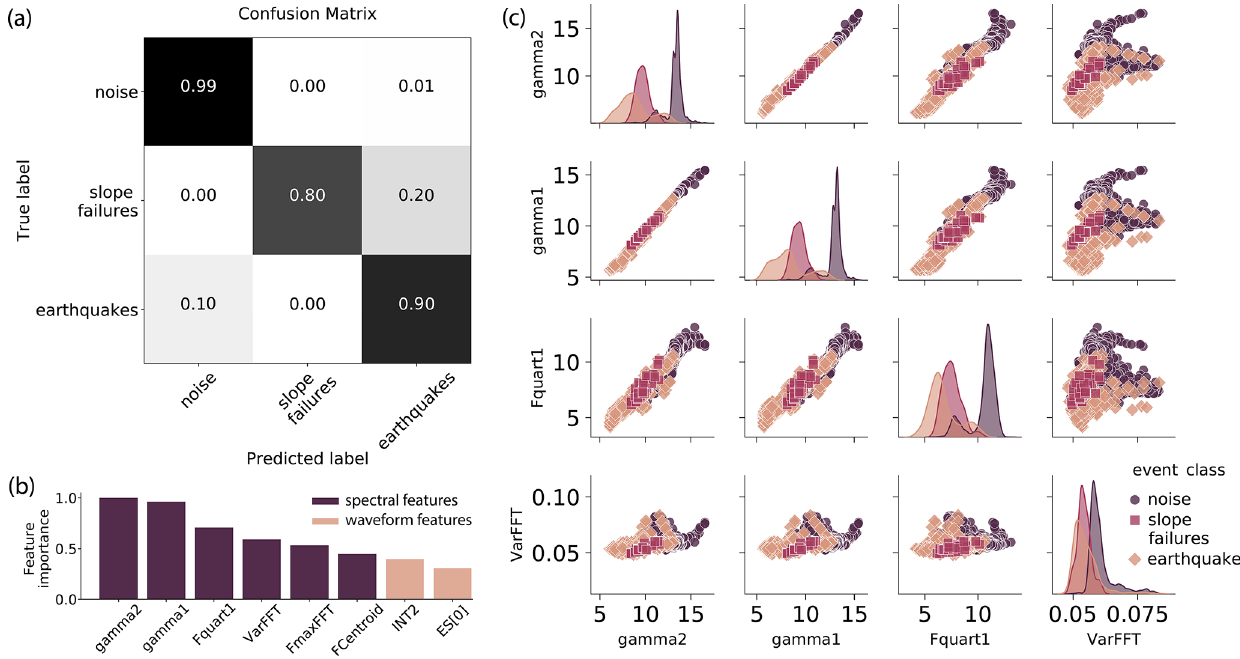
Figure 7. Confusion matrix and feature importance analysis of the optimized classifier for the Pizzo Cengalo data set. (a) Normalized confusion matrix of final model test. The darker the colors, the higher the values. For an ideal classifier, all samples would be located on the diagonal. (b) Eight most distinct features normalized to one. Dark columns mark spectral features (characteristics of signal in frequency domain); light columns mark waveform features (characteristics of signal in time domain). Labels: spectral gyration radius (gamma2), spectral centroid (gamma1), central frequency of the first quartile (Fquart1), variance of the normalized FFT (VarFFT), frequency at the maximum of the FFT (FmaxFFT), frequency at spectrum centroid (FCentroid), energy of the last 2 / 3 of the autocorrelation function (INT2), and the energy of the seismic signal in the frequency band of 1–3Hz (ES[0]) (Provost et al., 2017). (c) Pairplot of four most distinct features. Per cell two features are plotted against each other, except for diagonal. Diagonal shows univariate distribution of the feature. Colors mark different event